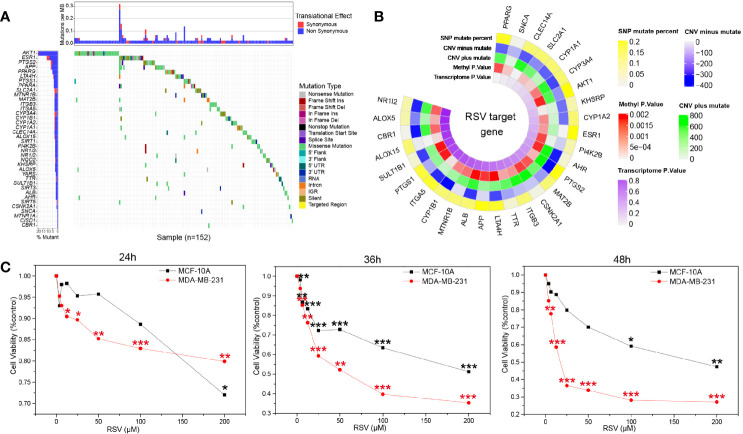
Resveratrol treatment potential in breast cancer. (A) Waterfall map of resveratrol target in drugbank and resveratrol target domain protein in protein data bank (TCGA download breast cancer data). (B) Multiomics circplot of resveratrol target in drugbank and resveratrol target domain protein in protein data bank (TCGA download breast cancer data). (C) Resveratrol inhibited the survival of MDA-MB-231 and MCF-10A cells at different concentrations (24 h, 36 h, 48 h). *p<0.05, **p<0.01, ***p<0.001.